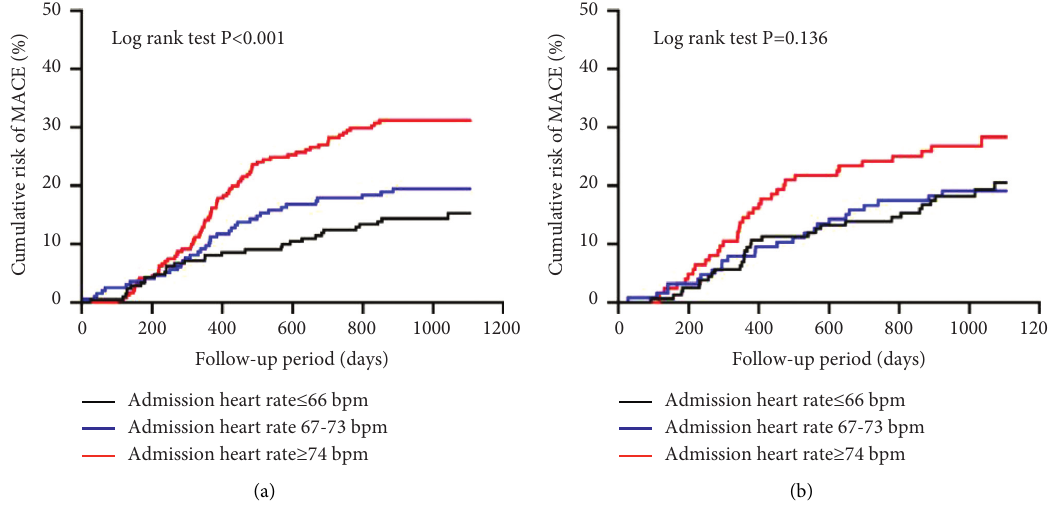
Figure 2: Kaplan–Meier curves of major adverse cardiovascular events stratified by admission heart rate tertiles among patients with (a) and without hypertension